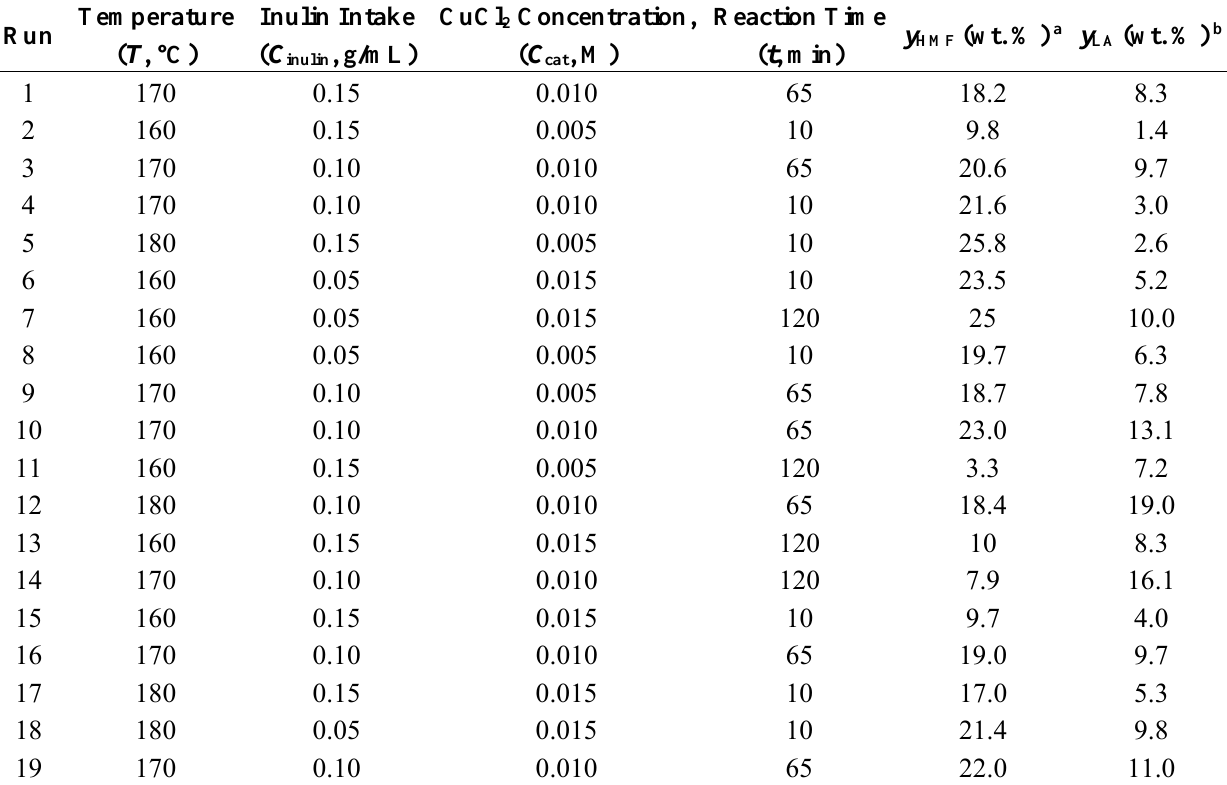
Table 3. Overview of experiments for the reaction of inulin in water using CuCl 2 as the catalyst. Temperature Run ( T ,